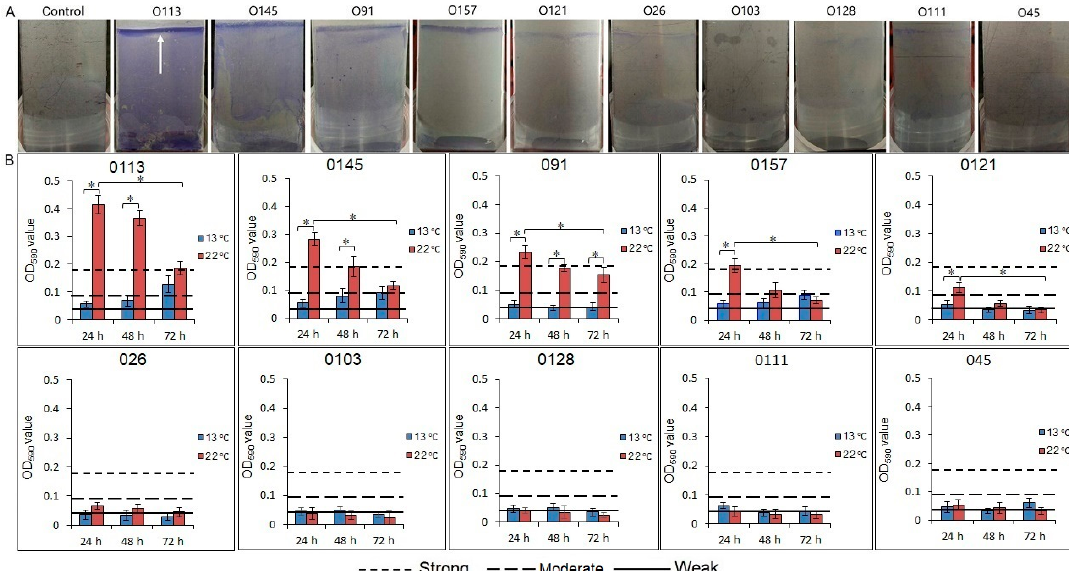
Figure 1. Biofilm formation of 10 STEC strains on a stainless steel surface. ( A ) Biofilms of 10 STEC strains were stained by crystal violet after incubation at 22 °C for 24 h. The arrow shows that some strains formed a dense pellicle at the air-liquid interface. ( B ) Biofilm formation of 10 STEC strains in M9 medium at 22 °C or 13 °C after 24, 48, and 72 h. The vertical axis represents the average of OD values, determined at 590 nm. Horizontal lines represent the cutoff values between weak, moderate, and strong biofilm producers. The cutoff optical density value (ODc) of 0.043 is defined as three standard deviations above the mean OD of the negative controls. Strains were classified as OD ≤ ODc (0.043), no biofilm producer, ODc < OD ≤ 2 × ODc, weak biofilm producers, 2 × ODc < OD ≤ 4 ×